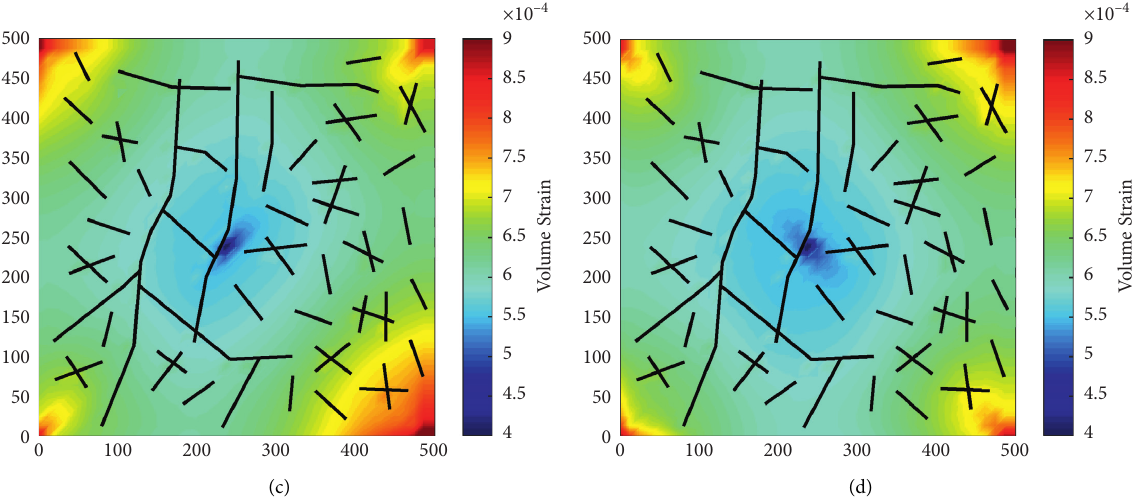
Figure 29: Volume strain distributions for (a) Case 1, (b) Case 2, (c) Case 3, and (d) Case 4 after 10000 days.